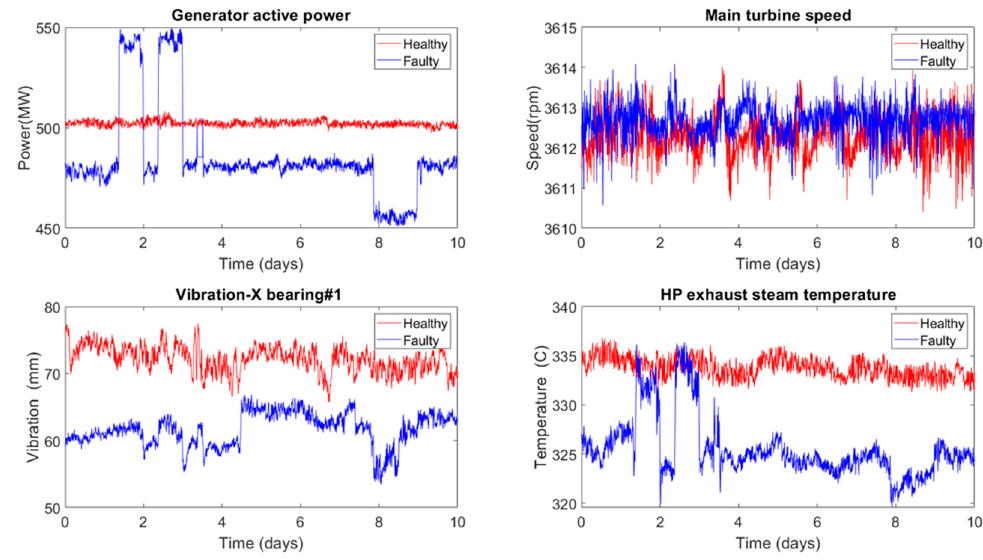
Figure 13. Sensor data showing the healthy (normal) and the faulty state of the steam turbine with the corresponding generator active power.